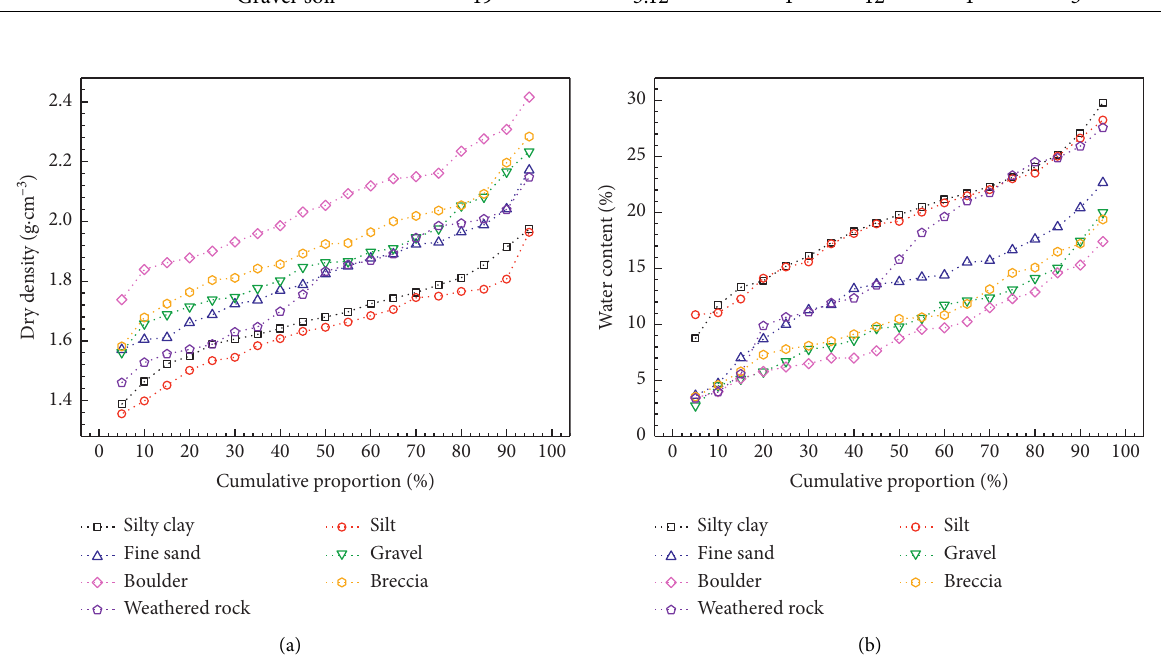
Figure 3: (a) Dry density and (b) water content probability distribution of soil